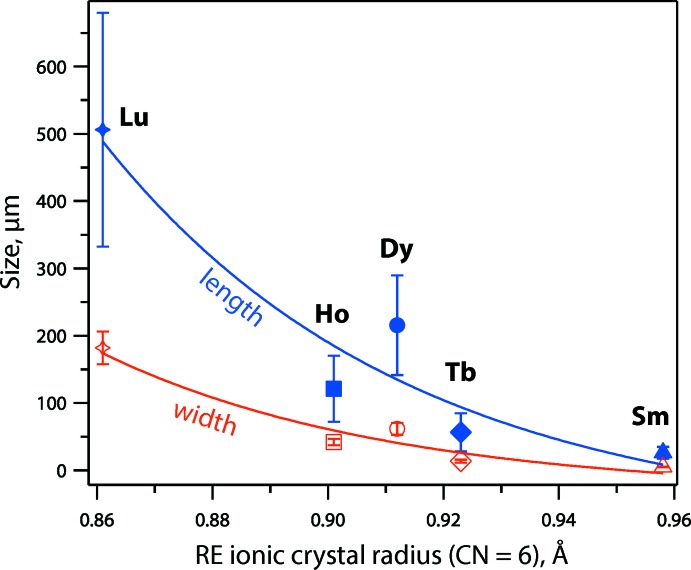
Summary of crystal size in terms of average length and width as a function of the average ionic crystal radii of the RE in the crystal structures (coordination number = 6) from Shannon (1976 ▸).